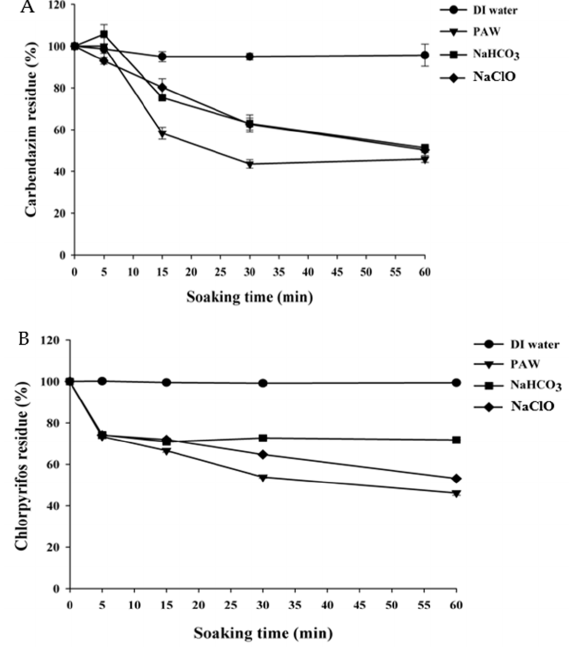
Figure 2. Degradation of ( A ) carbendazim and ( B ) chlorpyrifos residues in solution treated by DI water, PAW, NaHCO 3 , and NaClO as a function of treatment time.